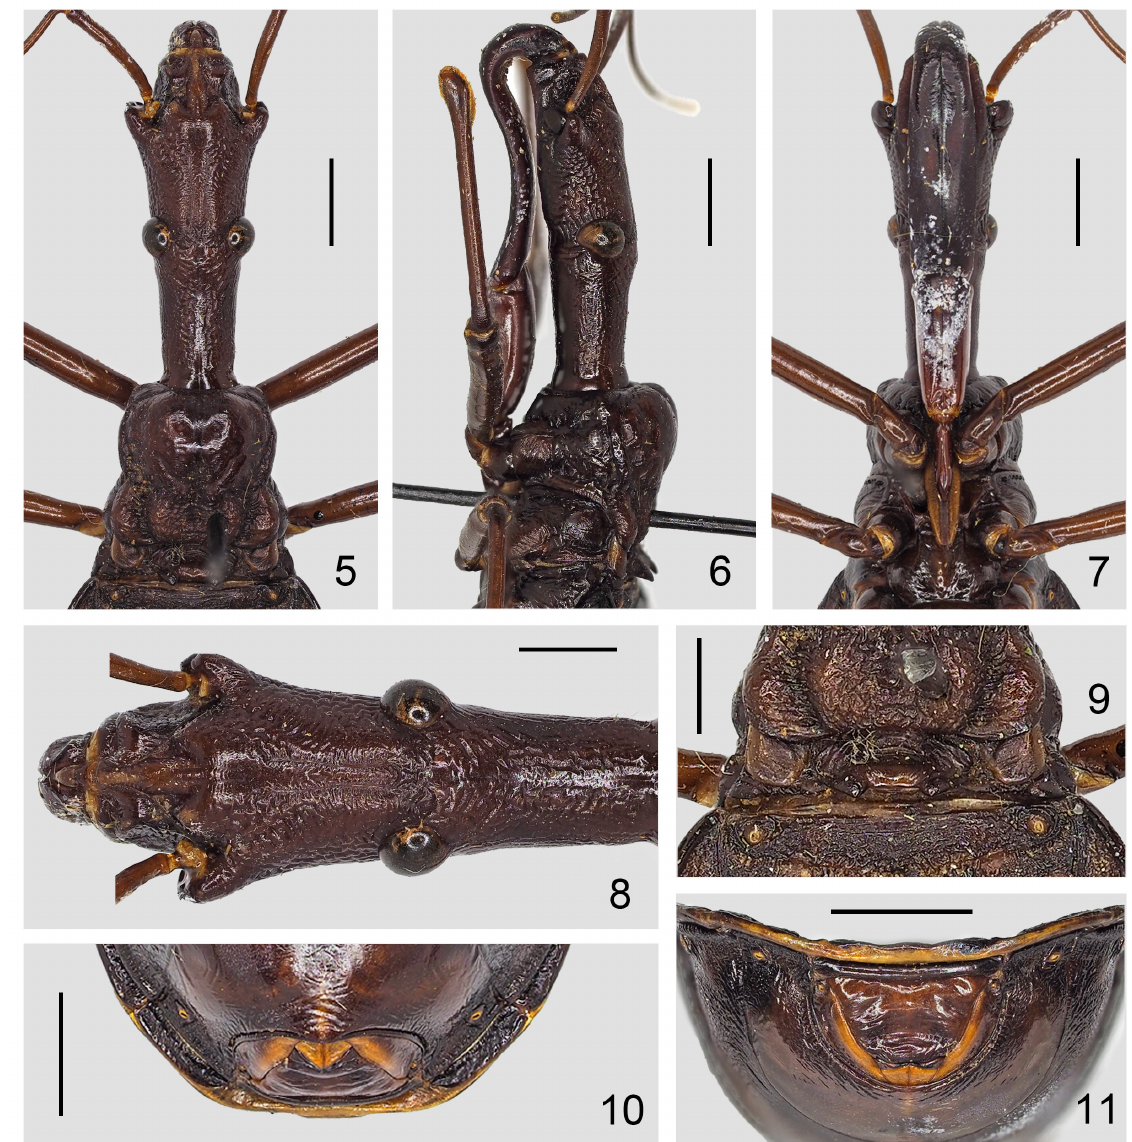
Figs 5–11. Xenorhyncocoris caraboides Miller, 1938, holotype, ♀ (NHMUK 013587632). 5 . Anterior part of body, dorsal view. 6 . Same, lateral view. 7 . Same, ventral view. 8 . Head, dorsal view. 9 . Scutellum, dorsal view. 10 . Posterior part of abdomen, ventral view. 11 . Same, caudal view. Scale bars: 5–7, 10– 11 = 3.00 mm; 8–9 = 2.00